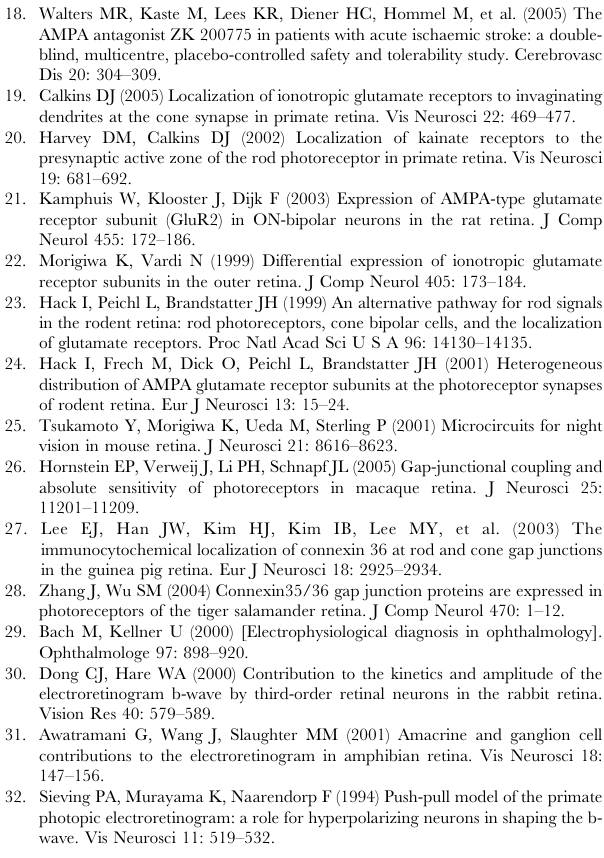
Table S4 Pupil light response. Data of the left eye for each group before infusion and 4 and 22 hours after infusion of ZK 200775. No significant changes occurred. Table S5 Amsler Card examination. Data of the left eye for each group before infusion and 4 and 22 hours after infusion of ZK 200775. No significant changes occurred. Table S6 Inclusion and exclusion